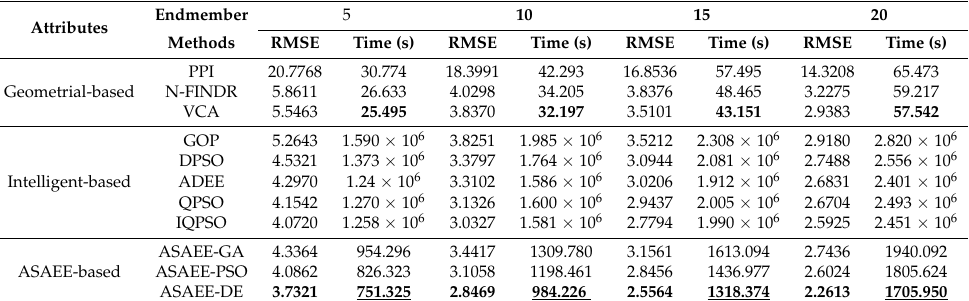
Table 3. Comparison of the proposed ASAEE framework with other algorithms on